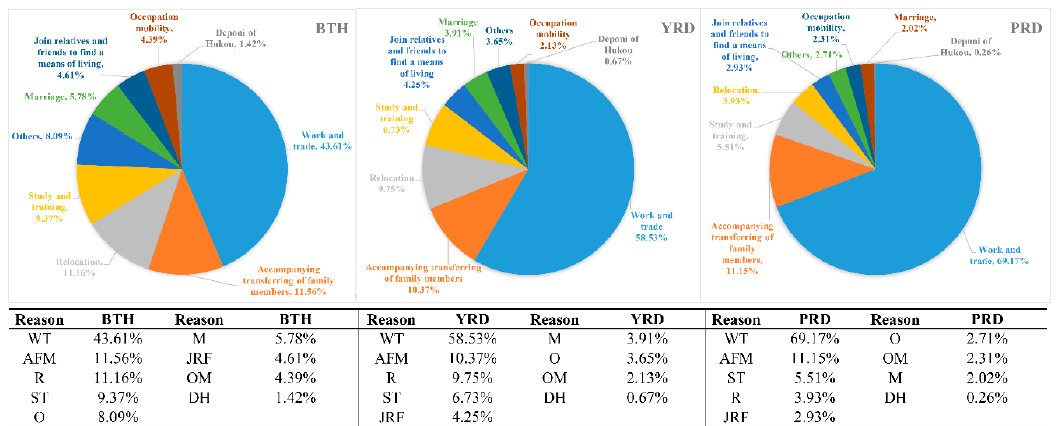
Figure 3. The percentage of migrant population based on diverse migration reason in the study area.